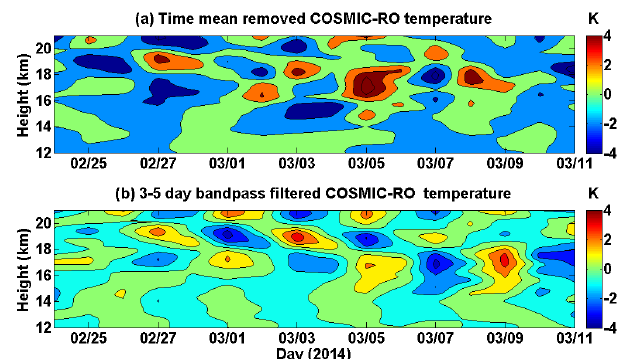
Figure 5. (a) Mean removed daily COSMIC RO temperature and (b) 3–5 day band-pass filtered daily COSMIC RO temperature for the period 24 February–11 March